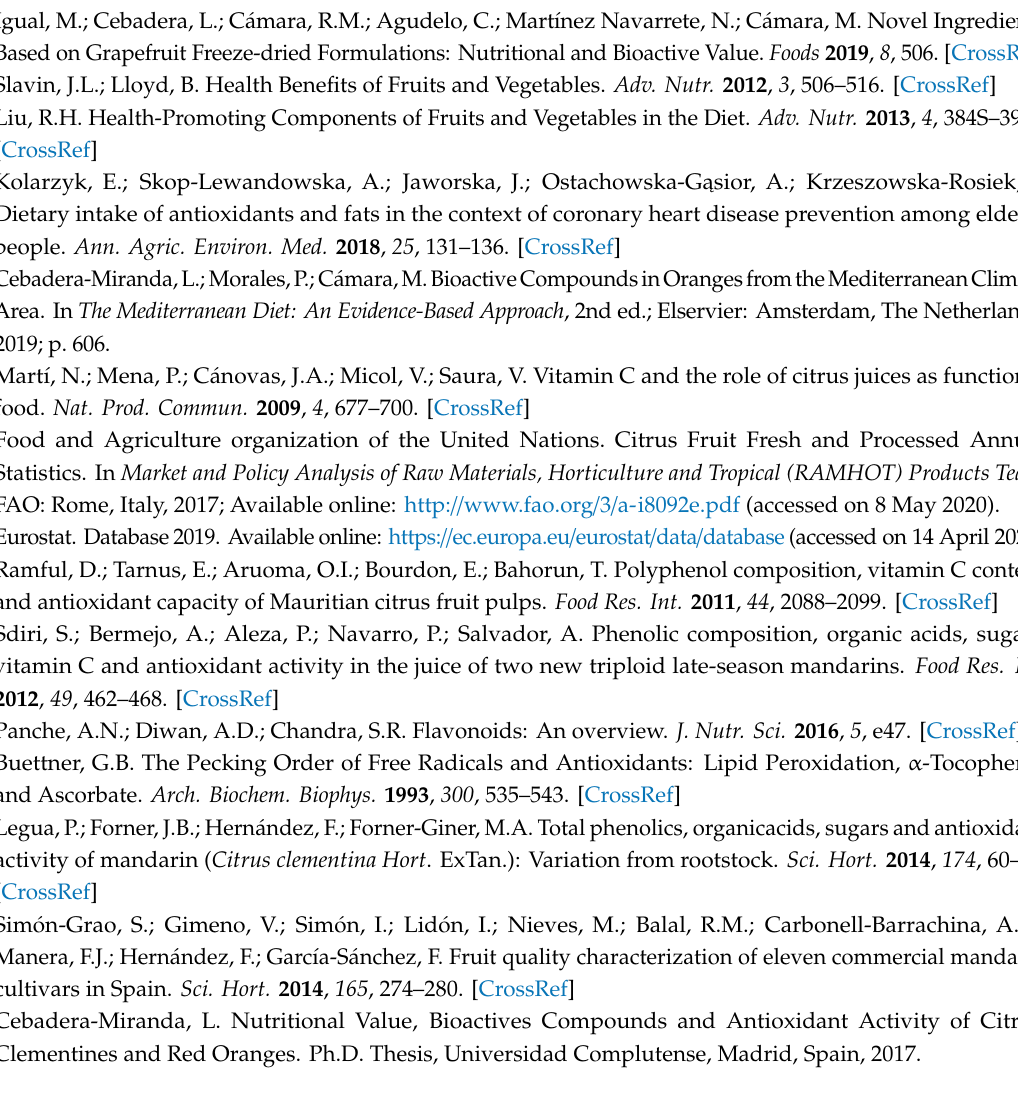
Table S1: Tentative identification of phenolic compounds in extra early clementine varieties, Citrus clementina Hort ex Tan. Table S2: Full quantification (mg / g of extract) of phenolic compounds in extra early clementine varieties, Citrus clementina Hort ex Tan. (mean ± SD, n =